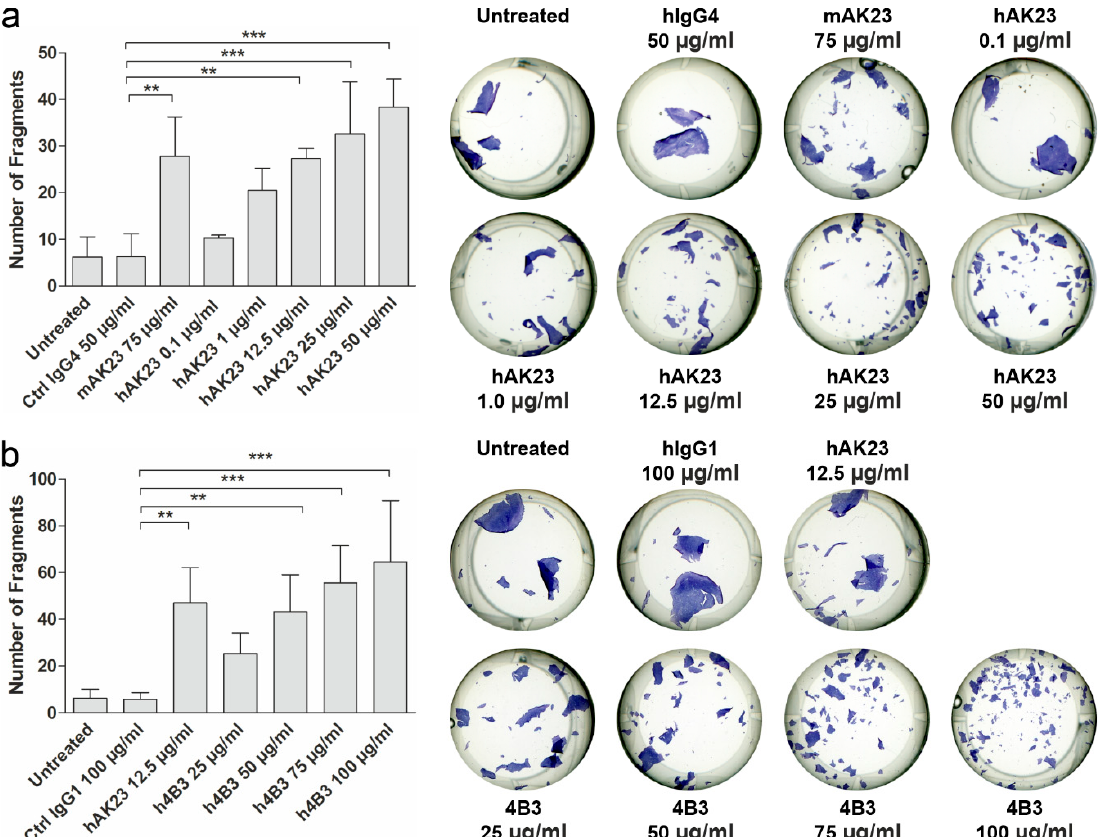
Figure 2. The anti-Dsg3 antibodies hAK23 and 4B3 are pathogenic in a monolayer dissociation assay. hTert keratinocytes were plated on 24-well plates, grown in KGM2 medium with 0.05 mM CaCl 2 until confluent and then switched to KGM2 with 2 mM CaCl 2 for 24 h. Thereafter, the cells were treated for 24 h with different amounts of the indicated antibodies ( a ) hAK23 or ( b ) 4B3, to induce acantholysis. As controls, mock incubation (untreated), an isotype-matched hIgG (hIgG4, 50 µg/mL), or hIgG1 (100 µg/mL) and mAK23 (75 µg/mL) were used. A monolayer fragmentation assay was performed, and the number of fragments was quantified using the ImageJ software. Representative images for each treatment are shown. The error bar represents the SD of the mean values obtained from at least four independent experiments, each of which was performed in triplicate. Statistical analysis was done using one-way analysis of variance (ANOVA) with Dunnett´s post-test. Statistically significant differences are indicated by asterisks. ** = p ≤ 0.01; *** = p ≤ 0.001.